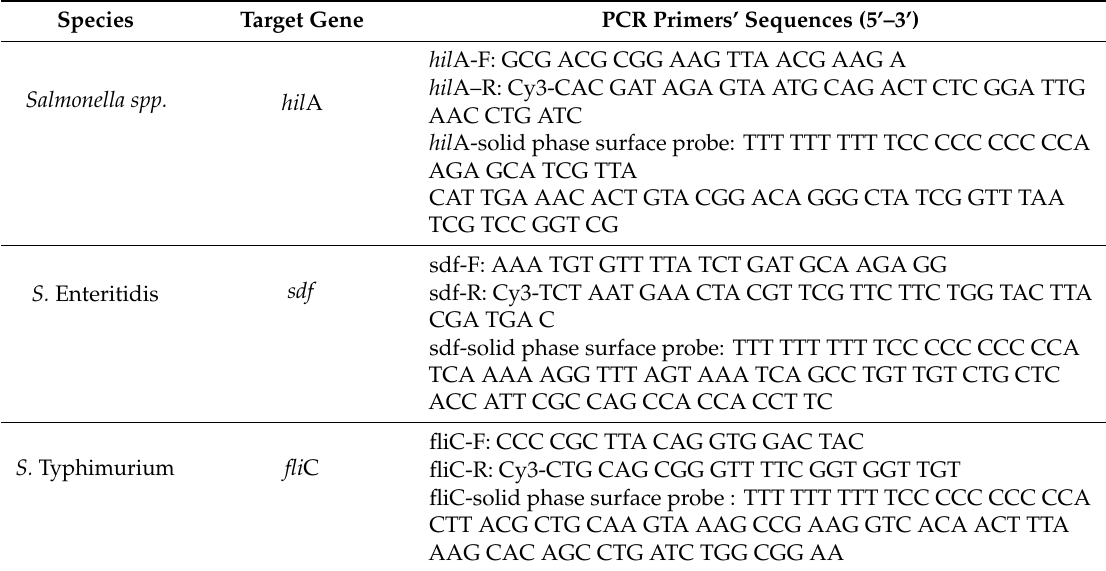
Table 1. List of primers used in this study